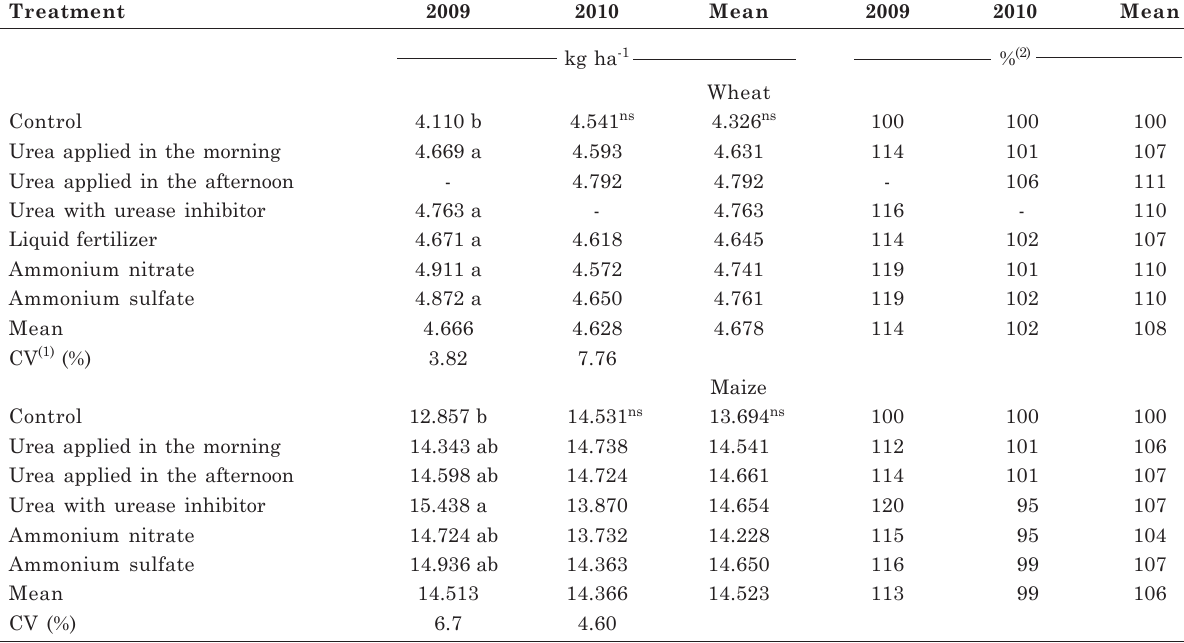
Table 5. Grain yield of wheat and maize in two growing seasons (2009 and 2010) as affected by different N